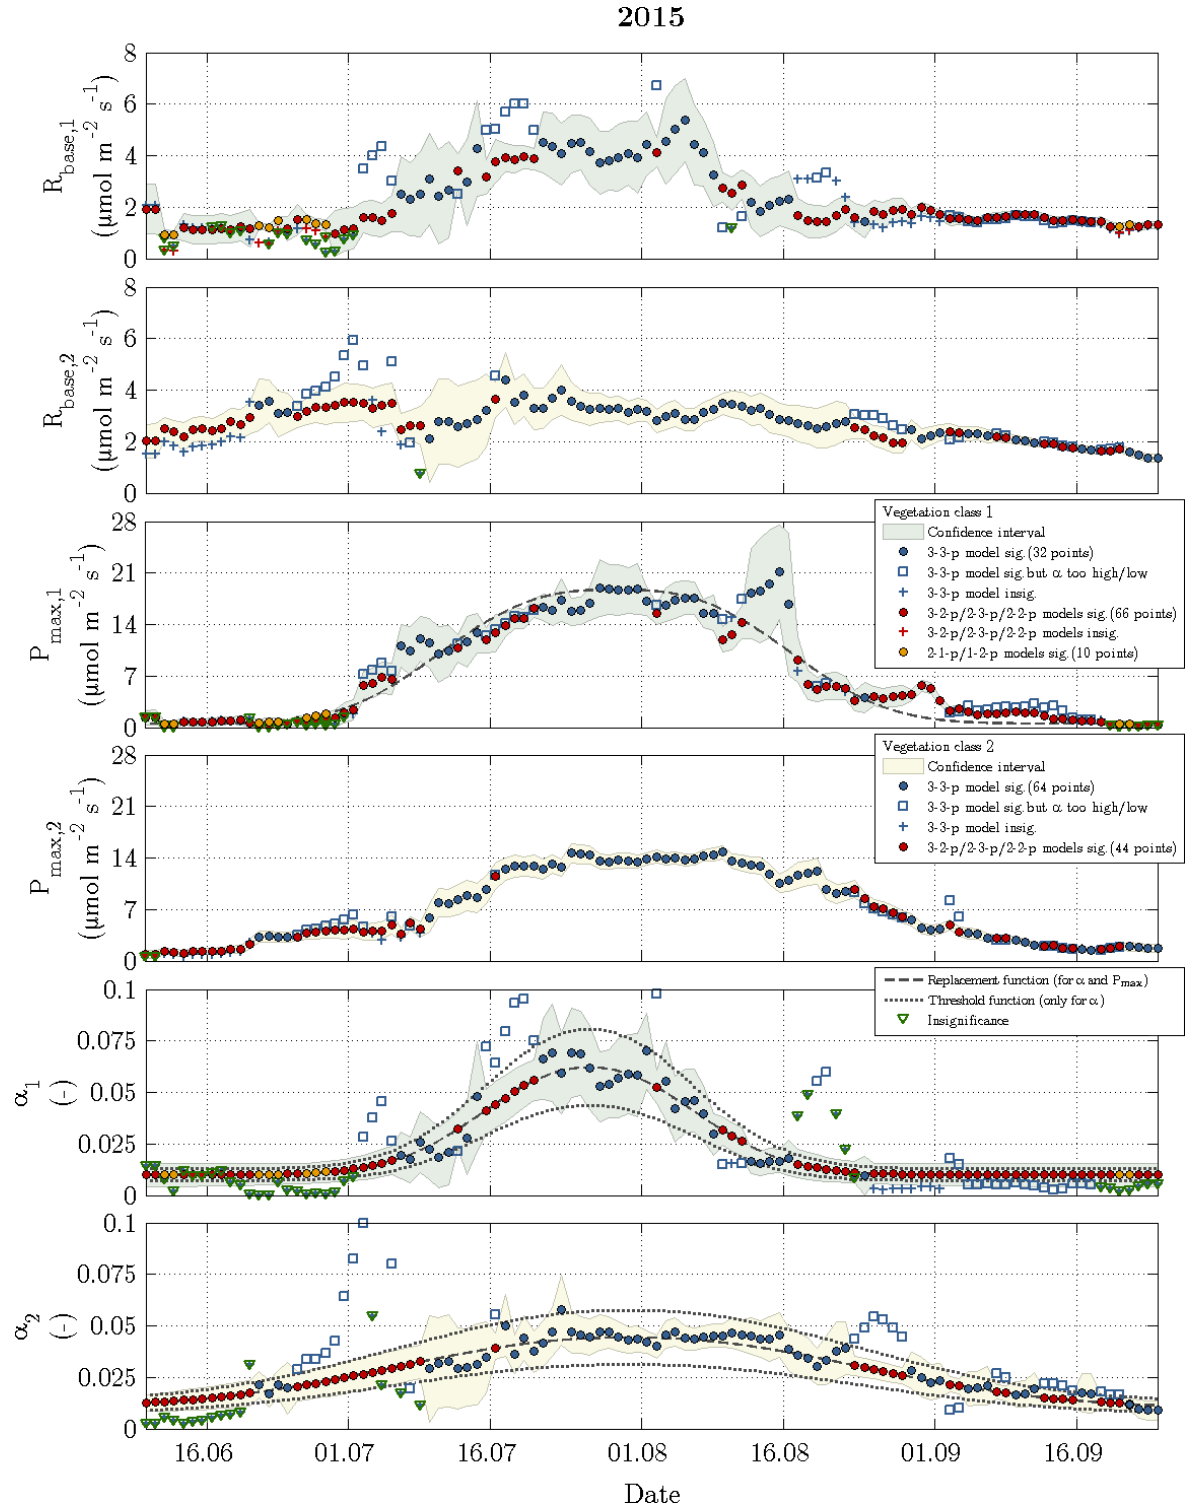
Figure 7. Time series of fitting parameters in 2015 with the same symbols and colours as utilised in the previous